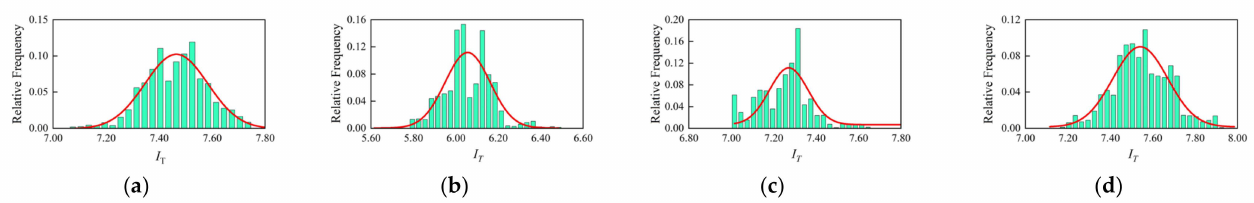
Figure 15. Posteriori relative frequency distribution of member 1. ( a ) Healthy; ( b ) failure of x - directional support restraint; ( c ) failure of y -directional support restraint; ( d ) failure of z -directional support restraint.